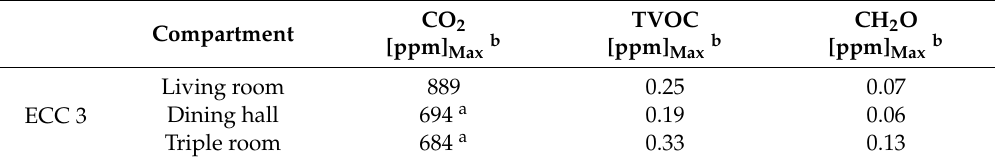
Table 12. Statistical data of the pollutants recorded in ECC 3 compartments: 1 st trial